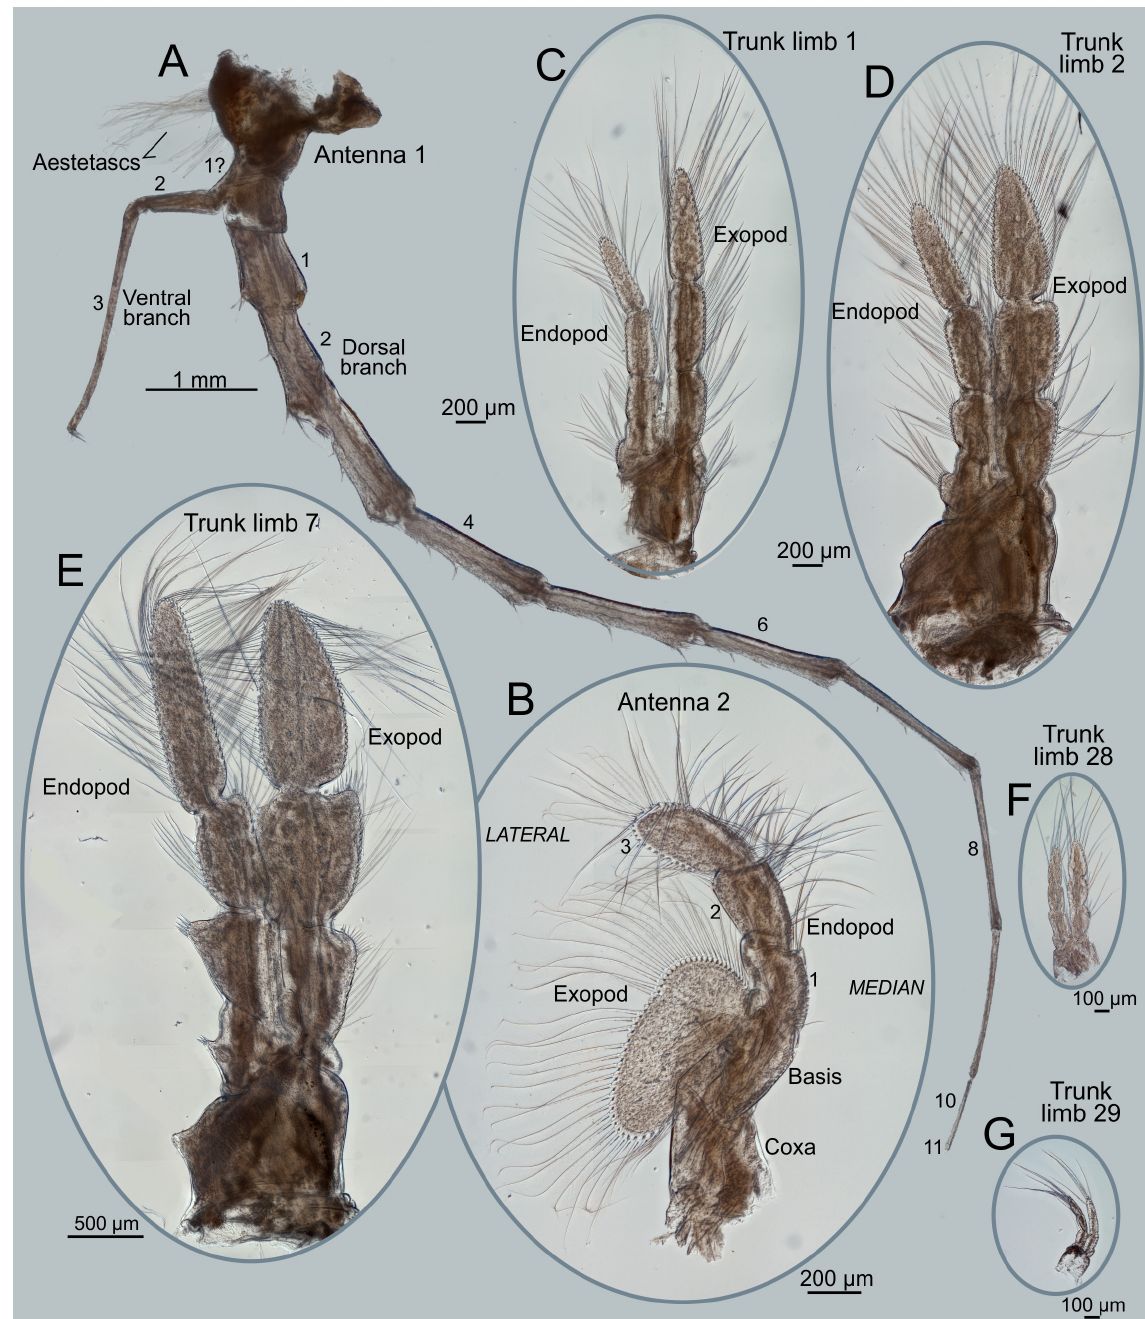
Fig. 4. Godzillius louriei sp. nov., holotype (NHMD 669698), light microscopy. A . Antenna 1 (a1), dorsal view. B . Antenna 2 (a2), dorsal view. C . Trunk limb 1. D . Trunk limb 2. E . Trunk limb 7. F . Trunk limb 28. G . Trunk limb 29. Small numbers represent segments of the dorsal and ventral branches of a1 and the exopod of